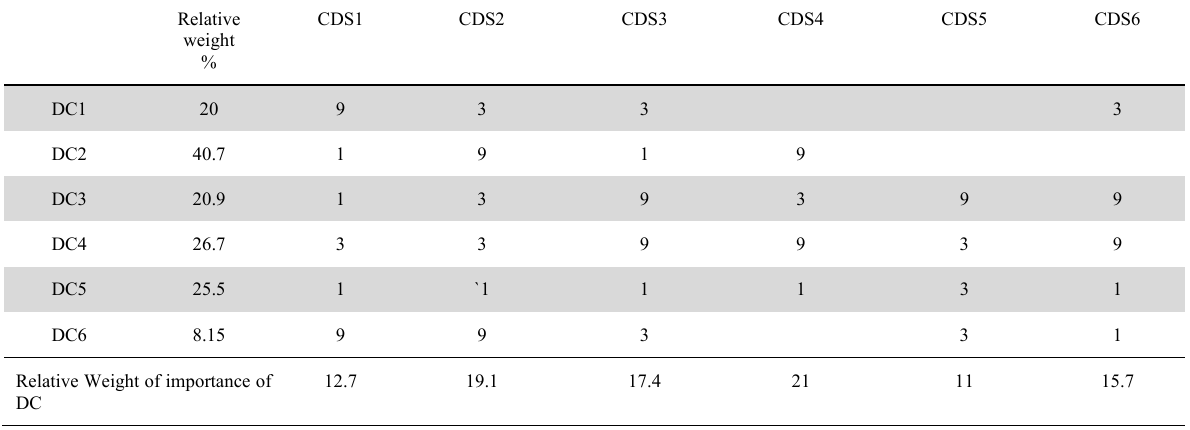
Initial stage transition probability Matrix (P) of risks factors during NPD concept design stage